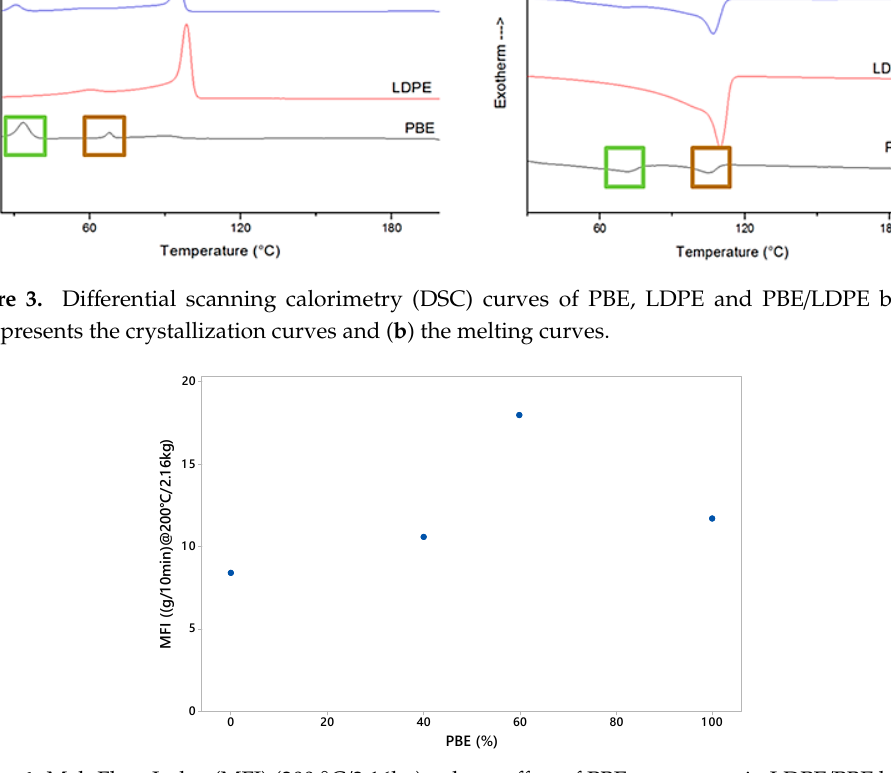
Figure 3. Differential scanning calorimetry (DSC) curves of PBE, LDPE and PBE/LDPE blends; ( a ) represents the crystallization curves and ( b ) the melting curves.